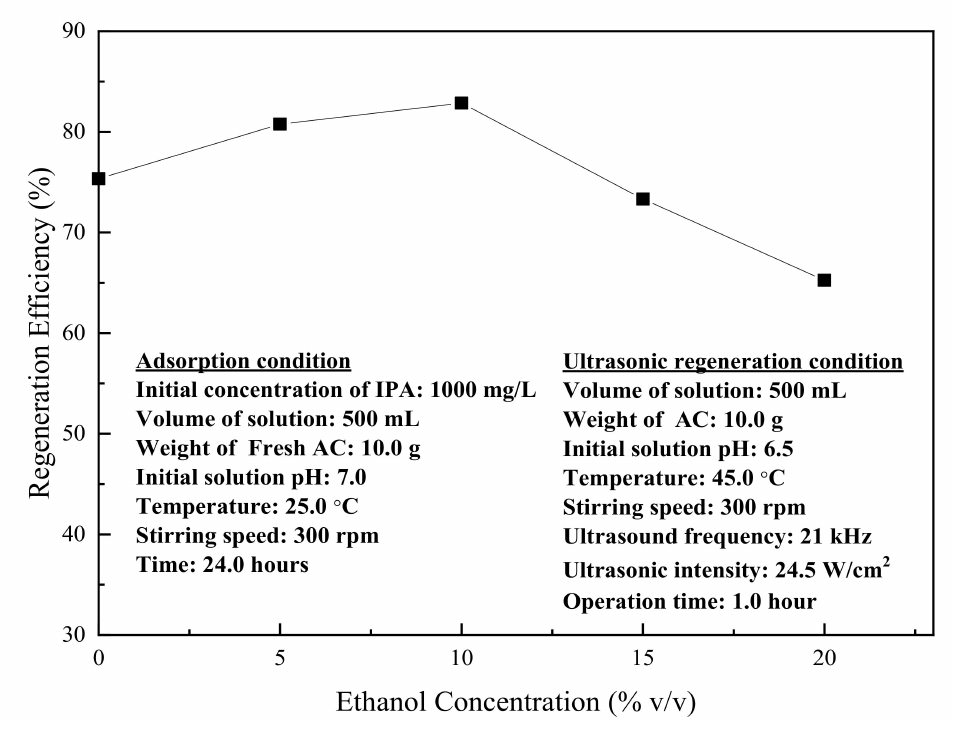
Figure 7. E ff ect of ethanol addition on the regeneration e ffi ciency of exhausted activated